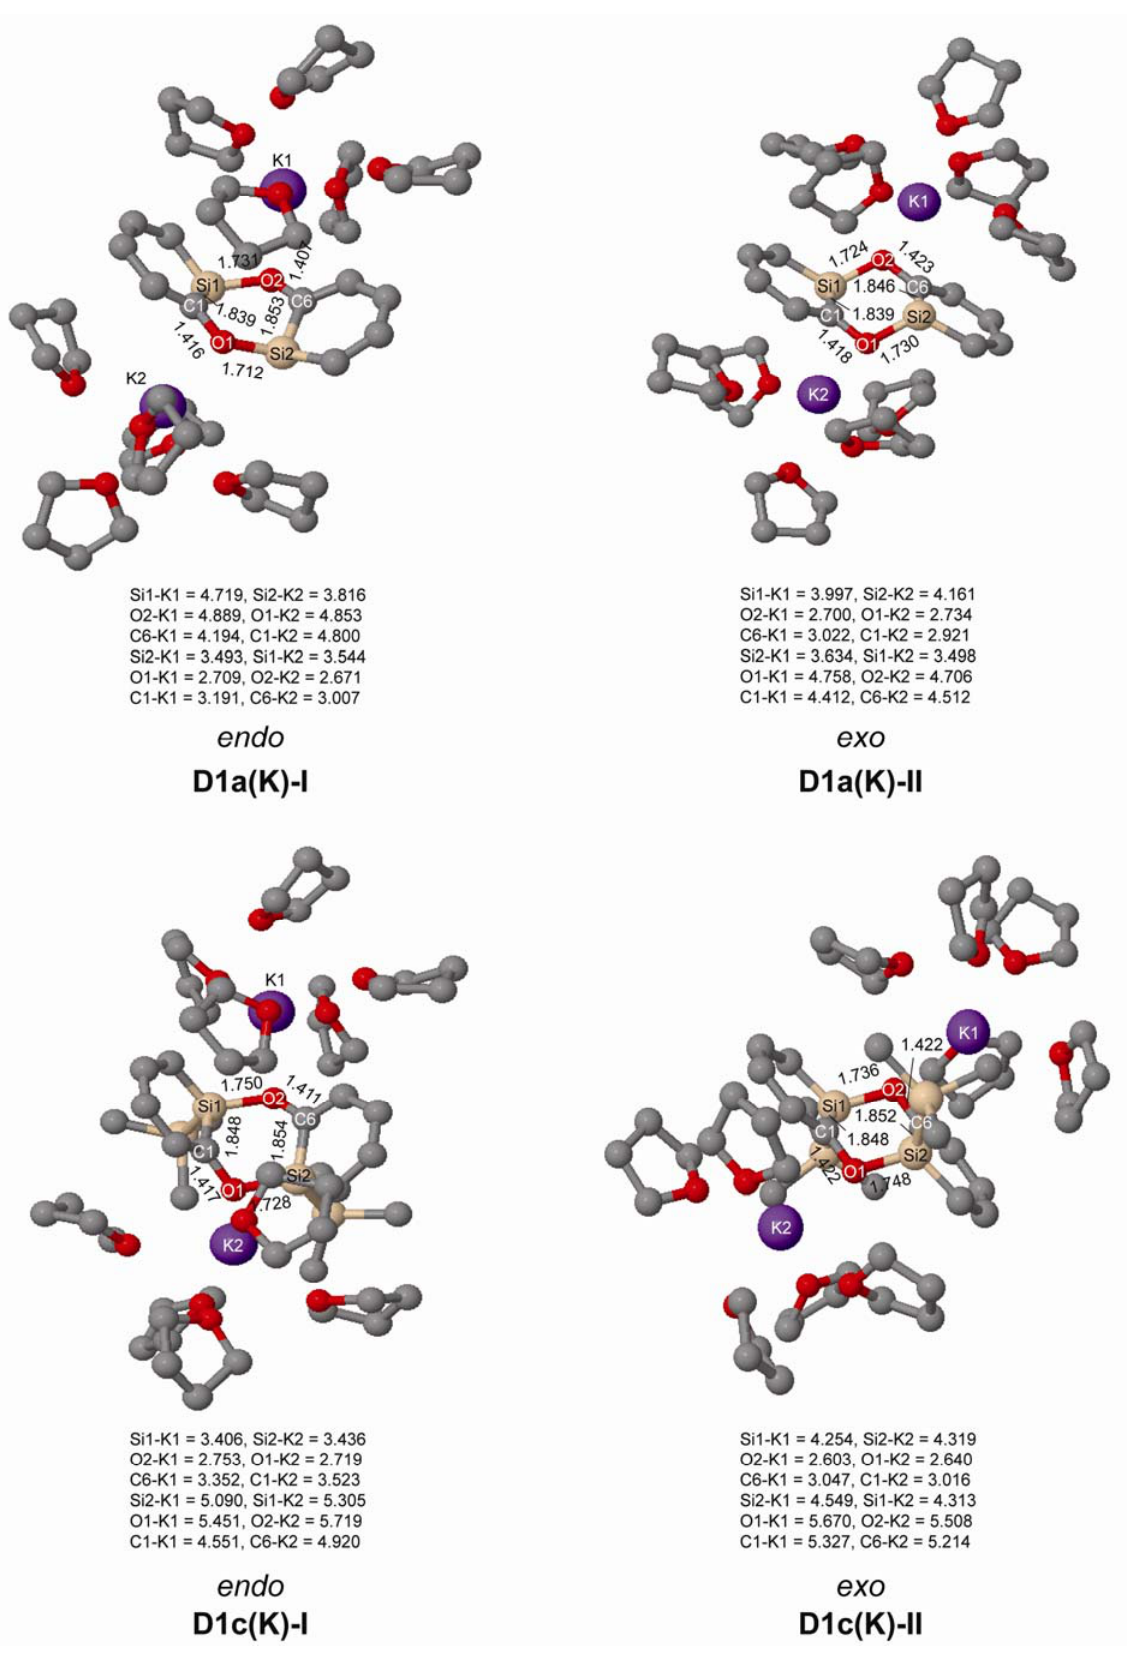
Figure 6. Geometries of the doubly Si-O bonded of 1a(K) and 1c(K) dimers solvated by K + (THF) calculated at M062X/6-31G(d) level. Distances in Å. Hydrogen atoms omitted 5 for